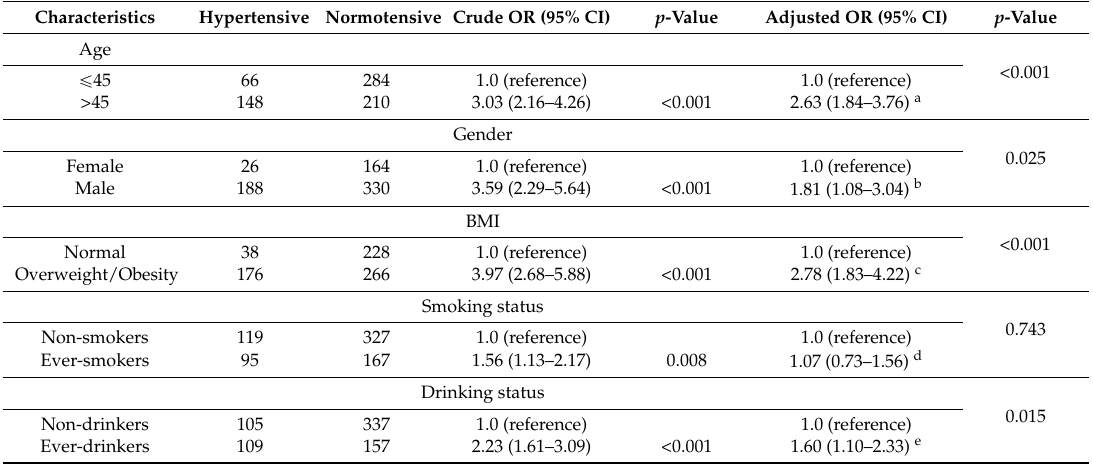
Associations of age, gender, BMI, smoking, and drinking status with the risk of essential